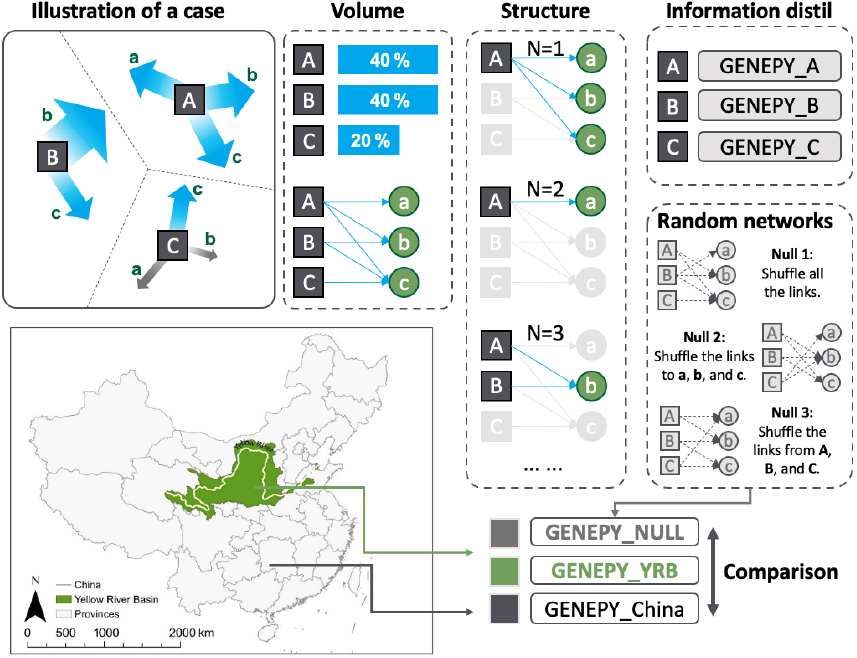
Figure 1. Virtual water transfers between regions through multiple dominant crops. When the proportion of VWF from a region is large enough when considering a specific crop, we establish a connection between the region and the crop. In that way, we abstract region–crop bipartite networks for analysis. Here, we give a more straightforward illustration of our method: (1) illustrating a nation comprised of three regions (A, B, and C) where three types of crops (a, b, and c) can be the productions for supporting virtual water flows (VWFs). Region B does not produce crop a, and region C produces a negligible crop a and b. (2) When considering VWF volume, it is hard to compare regions A and B, as they support 40% national total VWF. (3) However, when the structure is involved, their position in region–crop bipartite networks are different, typically in their differences of diversification ( N = 1), uniqueness ( N = 2), and competitiveness ( N = 3) (the parameter N refers to levels of decomposition, detailed interpretation in Sect. 2.4). (4) Therefore, considering both volume (by ignoring eligible VWF crops) and structure, the GENEPY index is a method for distilling information (see Sect. 2.3). Our main results derive from comparisons between indexes of YRB, China, and random networks (as a benchmark). We generated three different null models by shuffling links in different ways, and Table 2 gives them mathematical